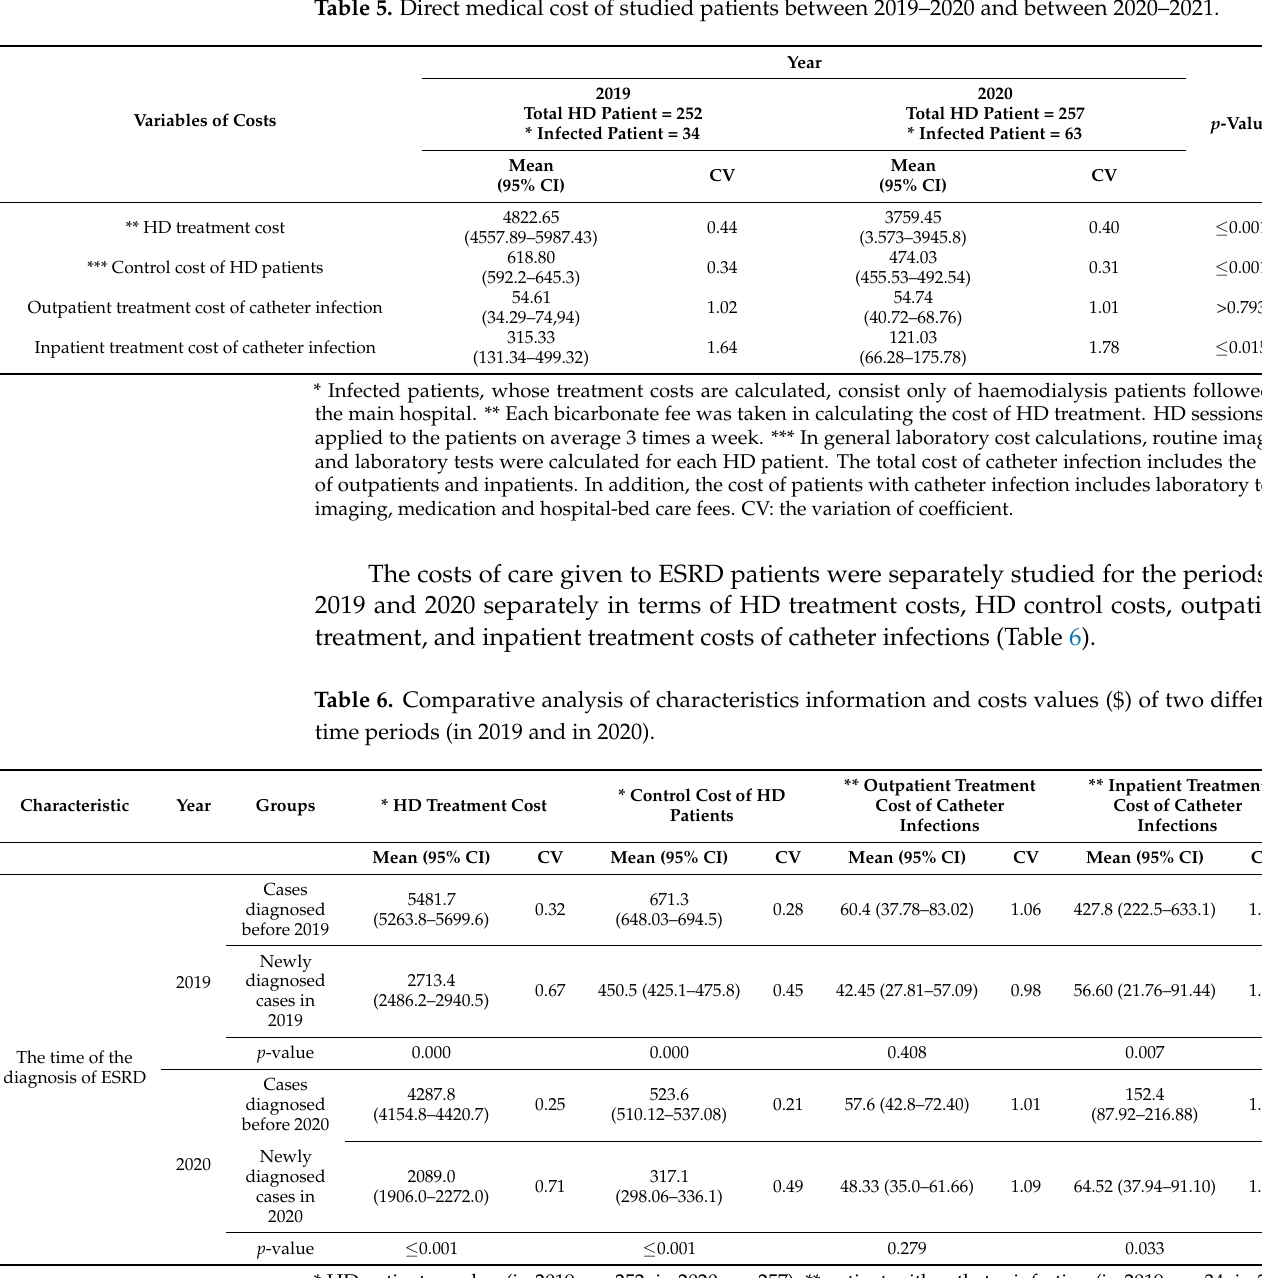
Table 5. Direct medical cost of studied patients between 2019–2020 and between 2020–2021.